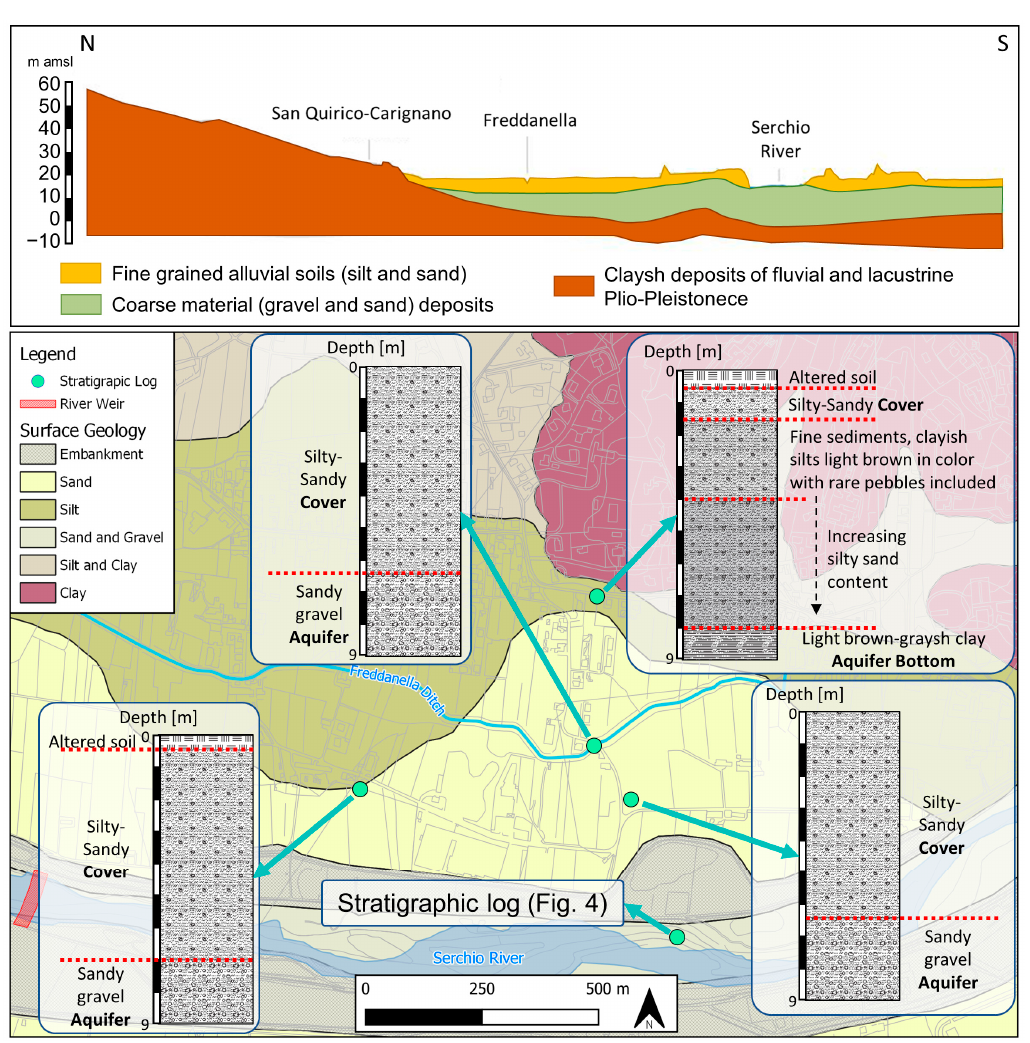
Figure 3. Simplified stratigraphic cross section (top) and detailed stratigraphic logs around the Serchio River RBF area